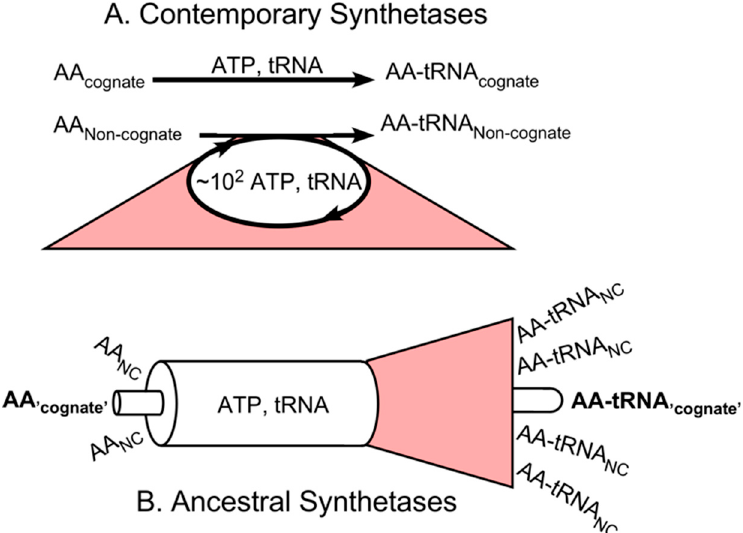
Figure 1. Dissipation of chemical free energy and information by aminoacyl-tRNA synthetases. ( A ) Contemporary aaRS are highly specific. When stereochemical differences between similar amino acids are small enough to permit ambiguity in a single binding event, specificity is enhanced by futile cycling of ATP consumption in the presence of non-cognate amino acids, dissipating chemical free energy. ( B ) Ancestral synthetases were very likely sufficiently less specific to allow incorporation into translated peptides of non-cognate amino acids at levels that led to the corruption of a large percentage of the translated peptides, leading to dissipation of the information embedded in the mRNA codescripts.